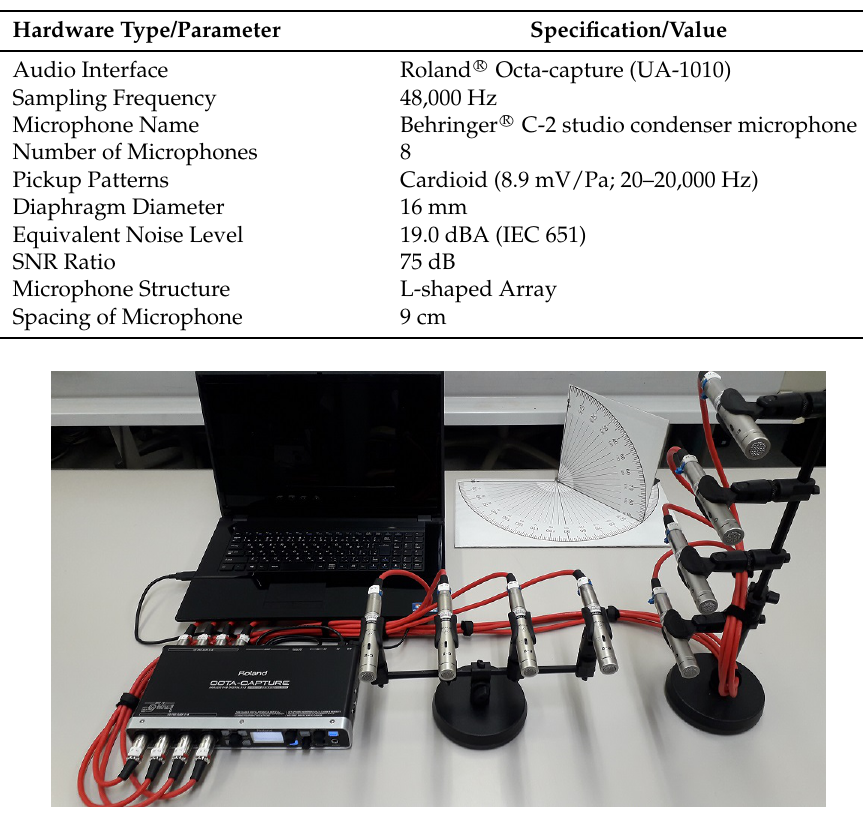
Figure 10. Photograph of the microphone array system.